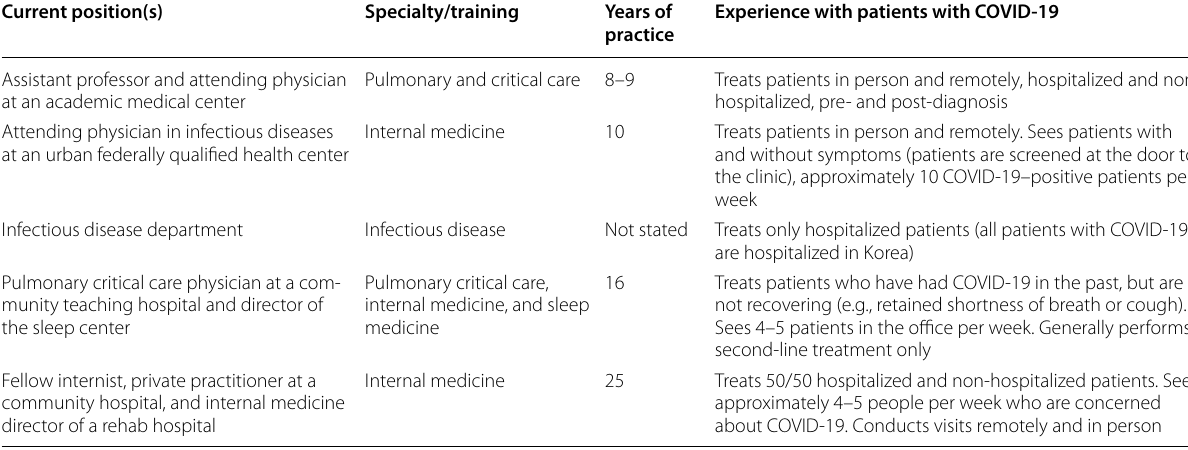
Table 2 Overview of clinician sample characteristics Current